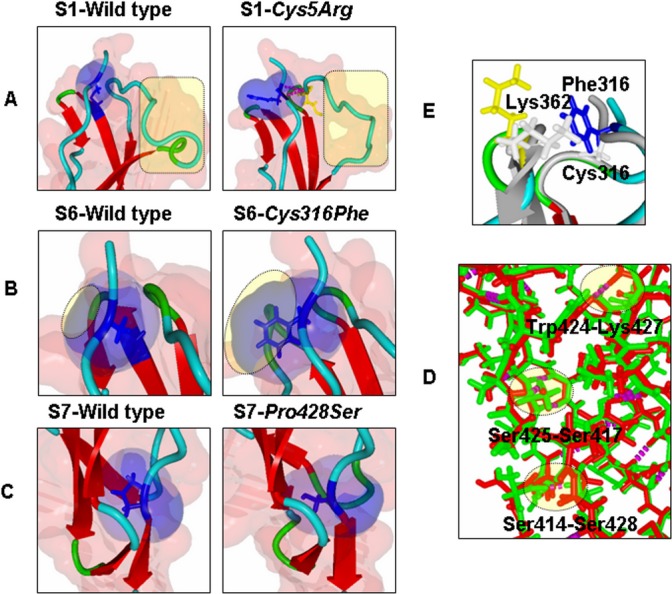
Close up views of the local molecular environment of reported missense mutations. (A–C) Depicts side-by-side local molecular environments for the mutations Cys5Arg, Cys316Phe, Pro428Ser with their wild-type sushi domains. The backbone is presented in ribbon format. Residue(s) of interest are depicted in stick format. Also depicted is the solvent accessible area (transparent red for the entire object and transparent blue for the residue of interest). In (A) and (B) it is quite apparent that mutation results in significant gain of accessible surface area. Also in (A) the mutated Arg residue is observed to form hydrogen bonds with Met 29. (C) Both the mutated Ser and the wild-type Proresidue look similar in terms of accessible surface areas and the secondary structure. (D) Close up view of superimposed structures of the mutated (for Cys316Phe) and wild-type S6 sushi domain. The backbones are depicted in ribbon format. The wild-type backbones as well as residues are colored gray while the backbone of the mutated sushi domain is colored with respect to its secondary structure. The mutated Phe316 residue is colored blue and the neighboring residue Lys362 is colored yellow in the mutated sushi domain. These residues are depicted as stick models in both wild-type and mutated sushi domain structures. The mutated Phe316 is surface exposed as opposed to the Cys316, which is completely buried. Also surface exposed is the Lys362 in the mutated structure while in the wild-type structure it is partially buried. (E) Superimposition of S7 wild-type sushi domain (green) and S7 mutated (for Pro428Ser) sushi domain (red) structures. Backbones are depicted as stick models. Hydrogen bonds are shown as magenta dots. The hydrogen bonds lost or gained are shaded yellow and also labeled with the residues participating in the particular bond. Structural alignments for (D) and (E) were done using the MUSTANG function embedded in YASARA.